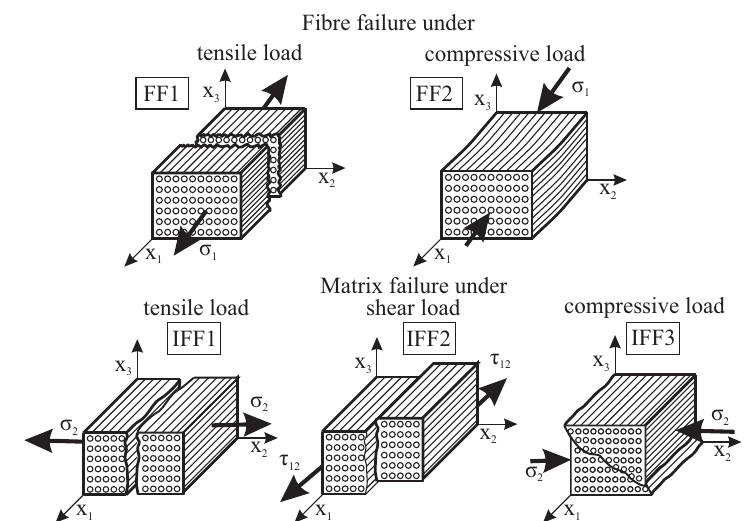
Figure 1. View of the failure modes of a brittle, transversally-isotropic material based on the Failure Mode Concept